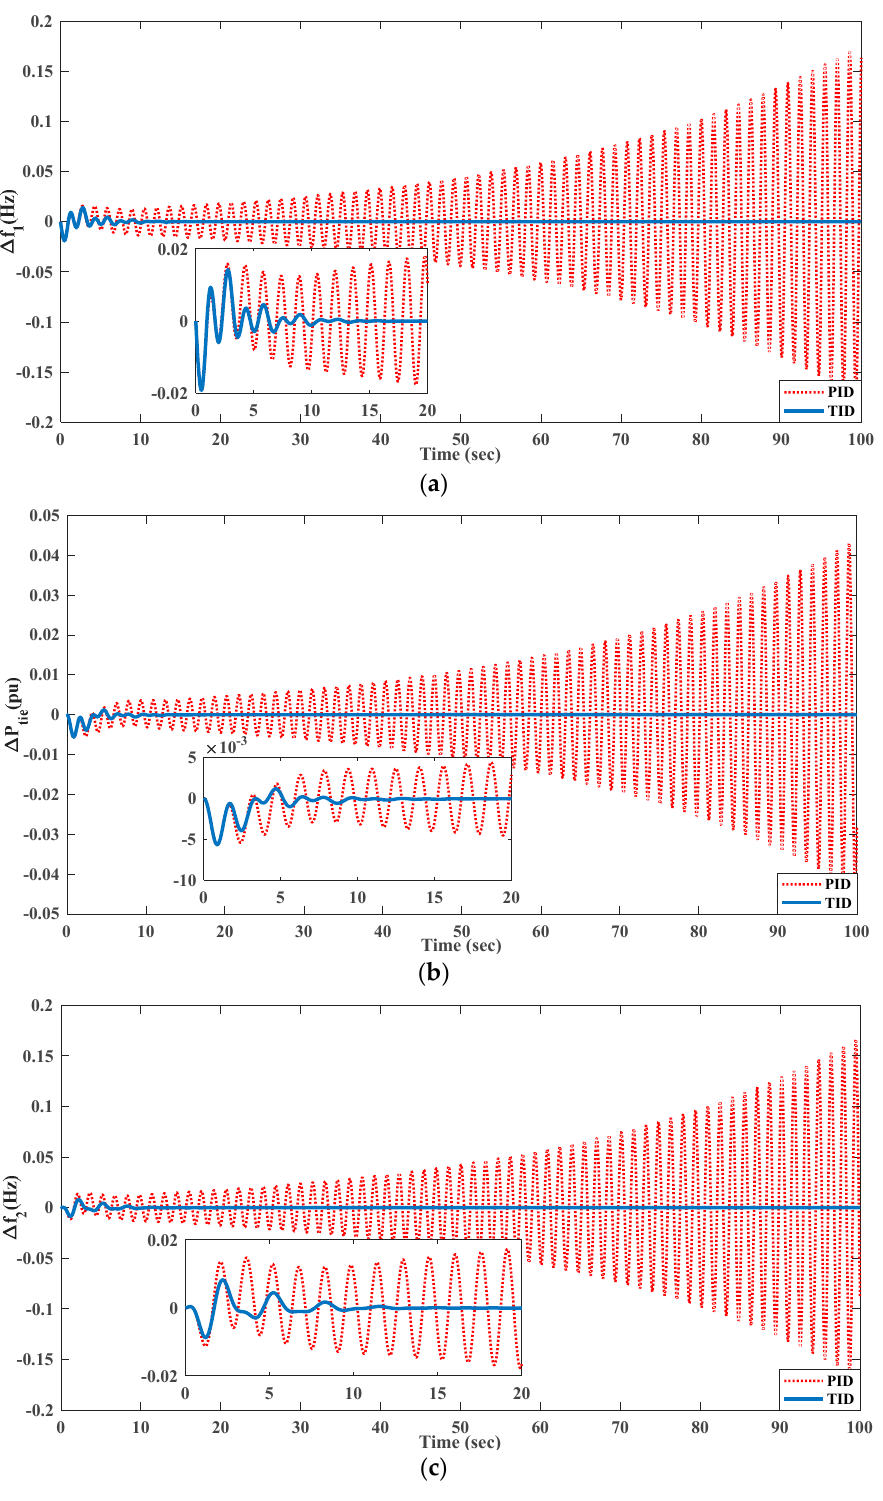
Figure 17. System dynamics for a time delay of 0.4 s. ( a ) Δ f 1 ; ( b ) Δ P tie ; ( c ) Δ f 2 .